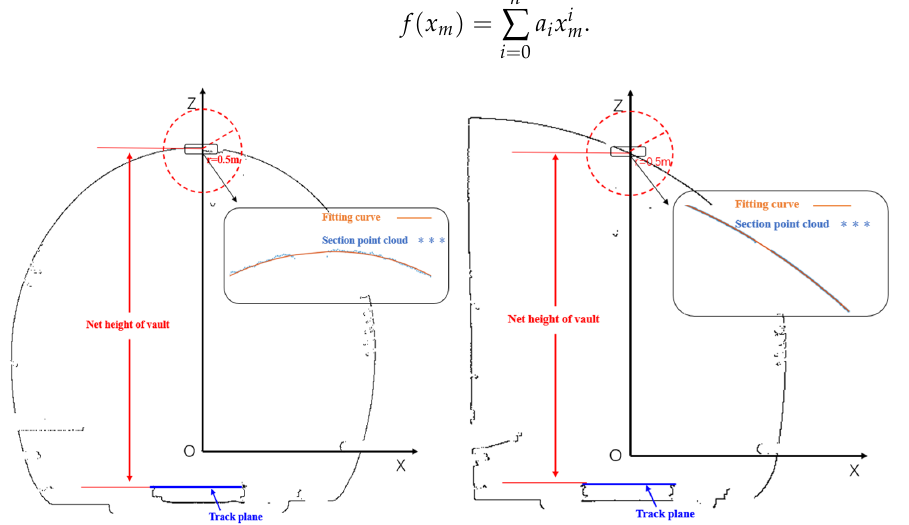
Figure 13. Schematic of net height of vault of different section types.